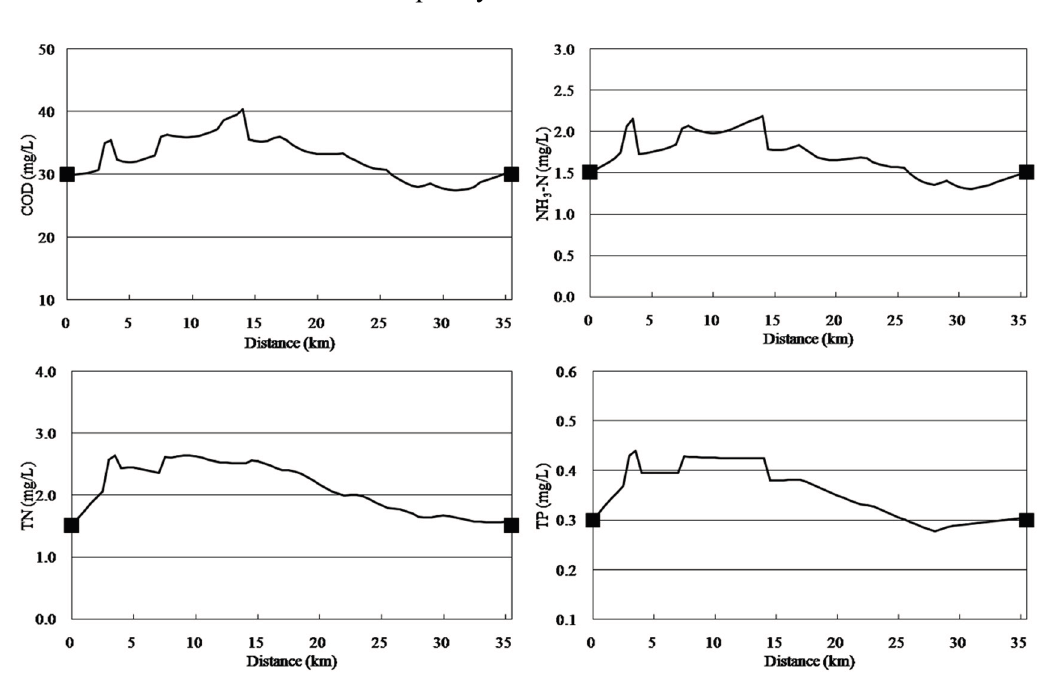
Figure 7. Simulation curves from implementing non-point source reduction, as required for the concentrations of various water quality variables to meet the